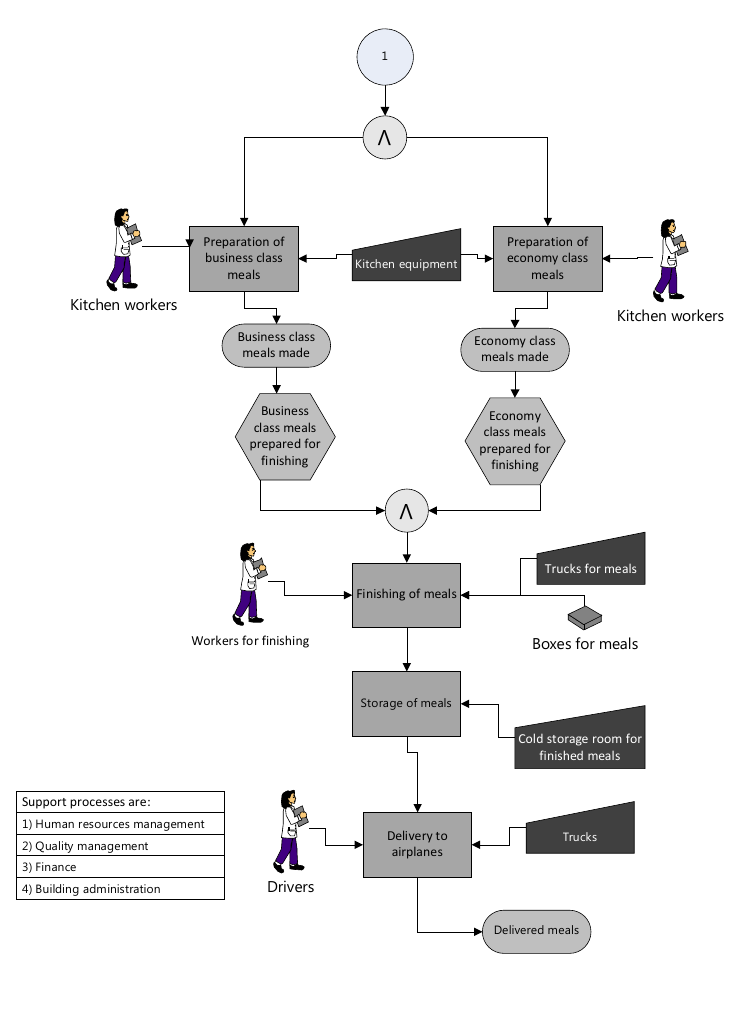
Figure – 1 Process model for catering deliveries to airplanes (part